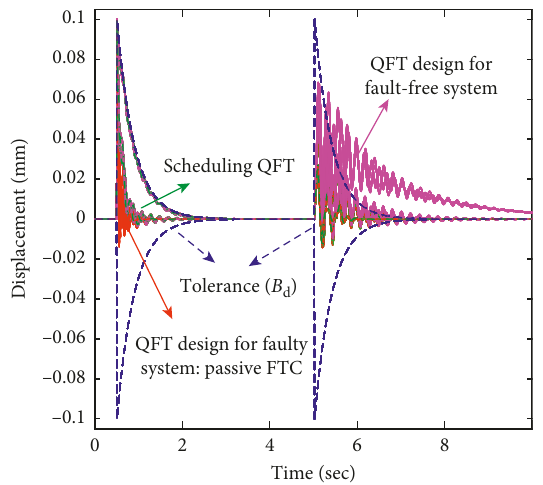
Figure 10: The closed-loop responses of the system (128 randomly selected plant from the plant set (5)) with the time-varying fault occurring at time t � 5sec for case (ii). Here, the responses for fault- free design, the design for faulty system, and the proposed scheduling approach are represented by “magenta solid line,” “red dashed line” and “green dashed-dotted line,” respectively.